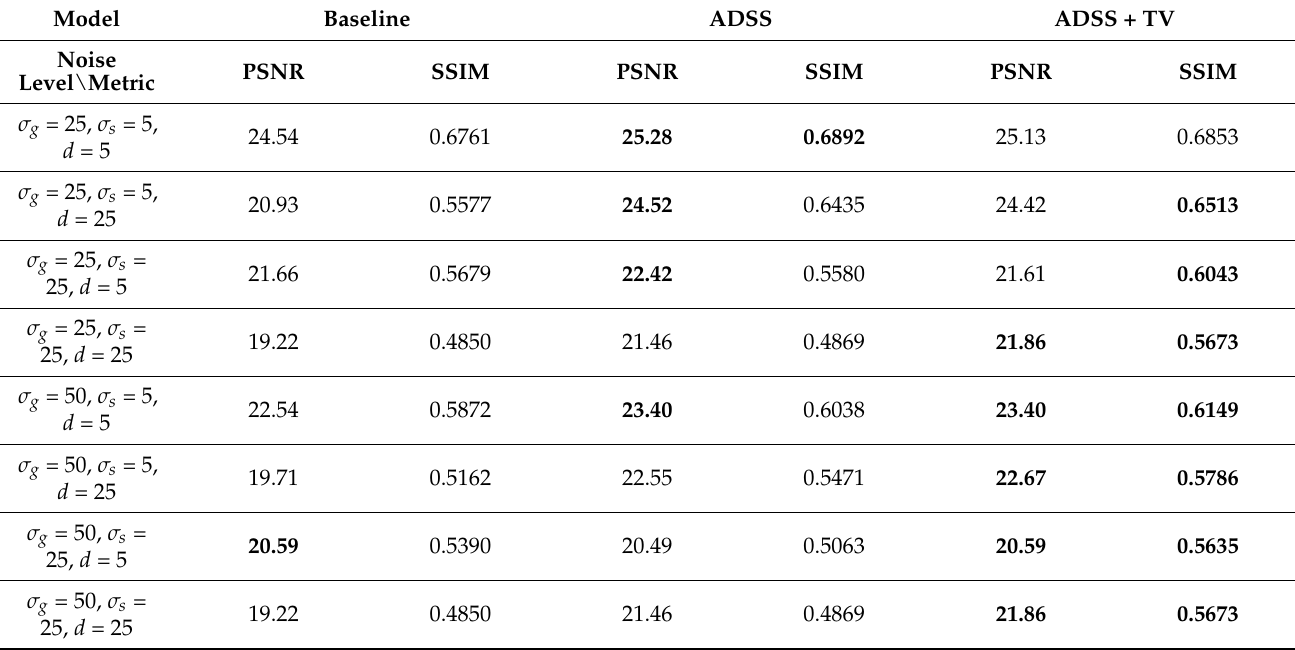
Table 3. Comparison of ADSS and general self-supervision loss. Average PSNR and SSIM for fusion noise on BSD68 validation set. The baseline uses only the structure of the proposed method with general self-supervision L 2 loss. Boldface denotes the best performance among Baseline, ADSS, and ADSS